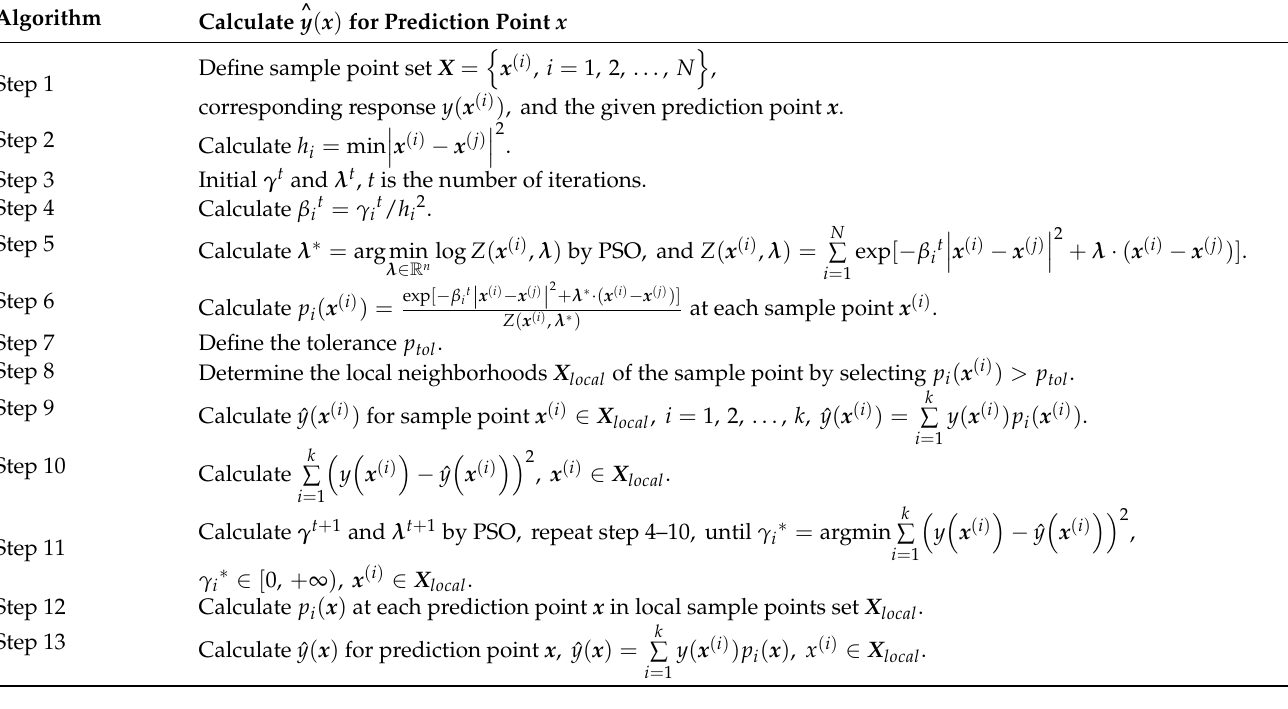
Table 1. The ALMESM algorithm